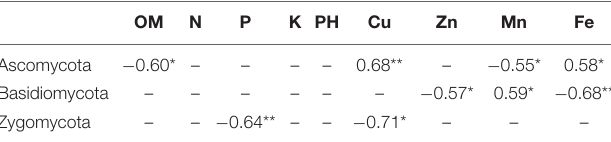
TABLE 2 | Correlation coefficients between the main microbial communities (phylum level) and soil physical and chemical properties. OM K